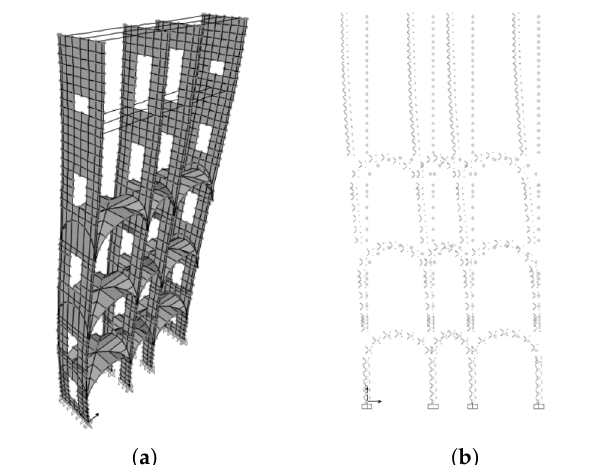
Figure 10. S y identification. Deformed configuration of the fine model in the: ( a ) 3D space; ( b ) y − z